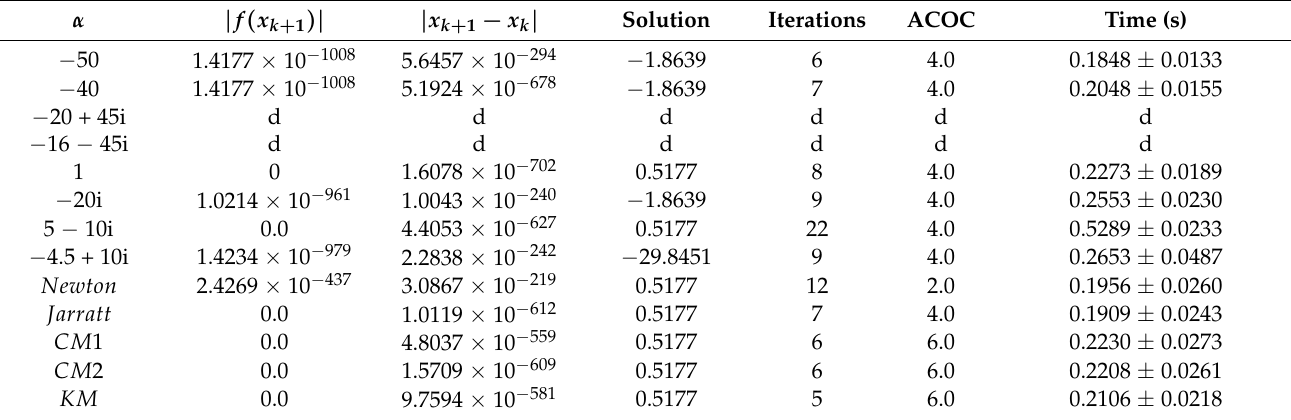
Table 4. f 2 ( x ) = cosx − xe x , x 0 =